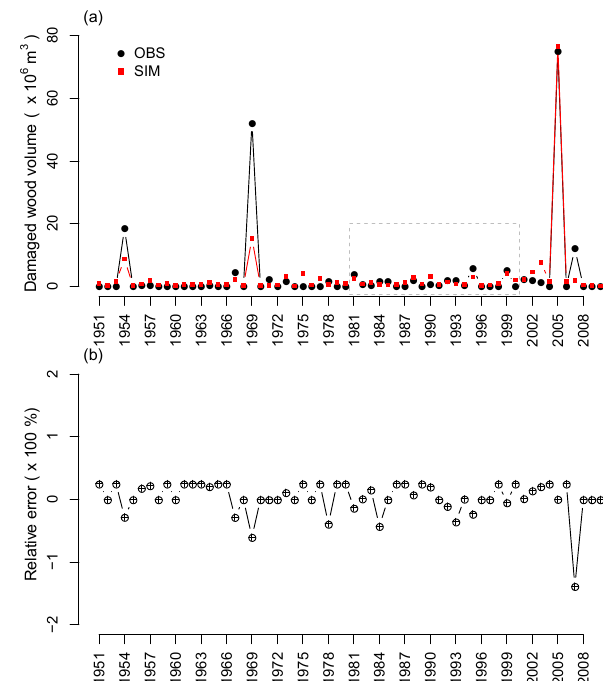
Figure 5. Sensitivity of the simulated storm damage over Swe- den between 1981 and 2000 for different values for the relax- ation parameter ( R f ) and the gust factor adjustment G adj (a) . Observed storm damage is extracted from Nilsson et al. (2004), Schlyter et al. (2006), Bengtsson and Nilsson (2007), and Gardiner et al. (2010). The relative model simulation error (calculated as (estimation − observation) / estimation) for the best-tuned case (b) .